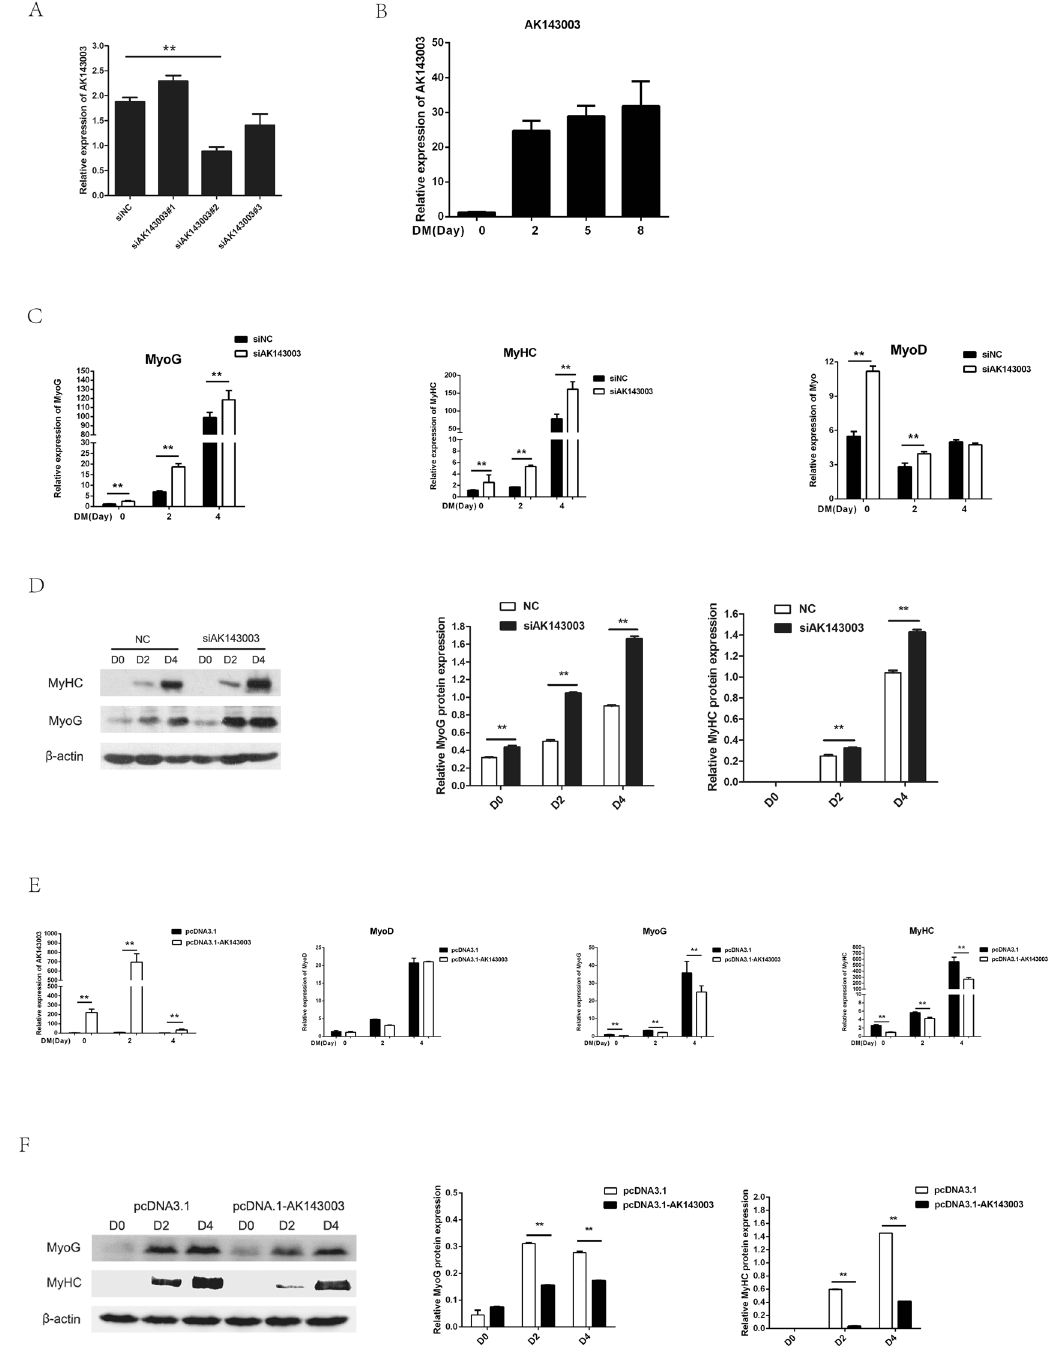
Figure 4. The function of AK143003 during C2C12 myoblasts differentiation. ( A ) Screening assay of siRNA of AK143003 showed the second siRNA have the highest interference efficiency. ( B , C ) the result of AK143003 interference during a 4-days differentiation course was showed in ( B ). The myogenic marker gene were upregulated after AK143003 silencing ( C ). ( D ) Knockdown of AK143003 increased the levels of MyoG and MyHC protein during a 4-days differentiation course. ( E ) The AK143003 overexpression results at diverse differentiation time. ( F ) The mRNA levels of skeletal muscle marker genes were decreased in cells from E. ( G ) Western blot result of indicated genes protein after enhancing the expression of AK143003. All the qPCR data were normalized to β -actin and presented as mean ± S.D. (n = 3). * p < 0.05, ** p < 0.01. The relative expression of protein levels represented by ratio of gray value to β